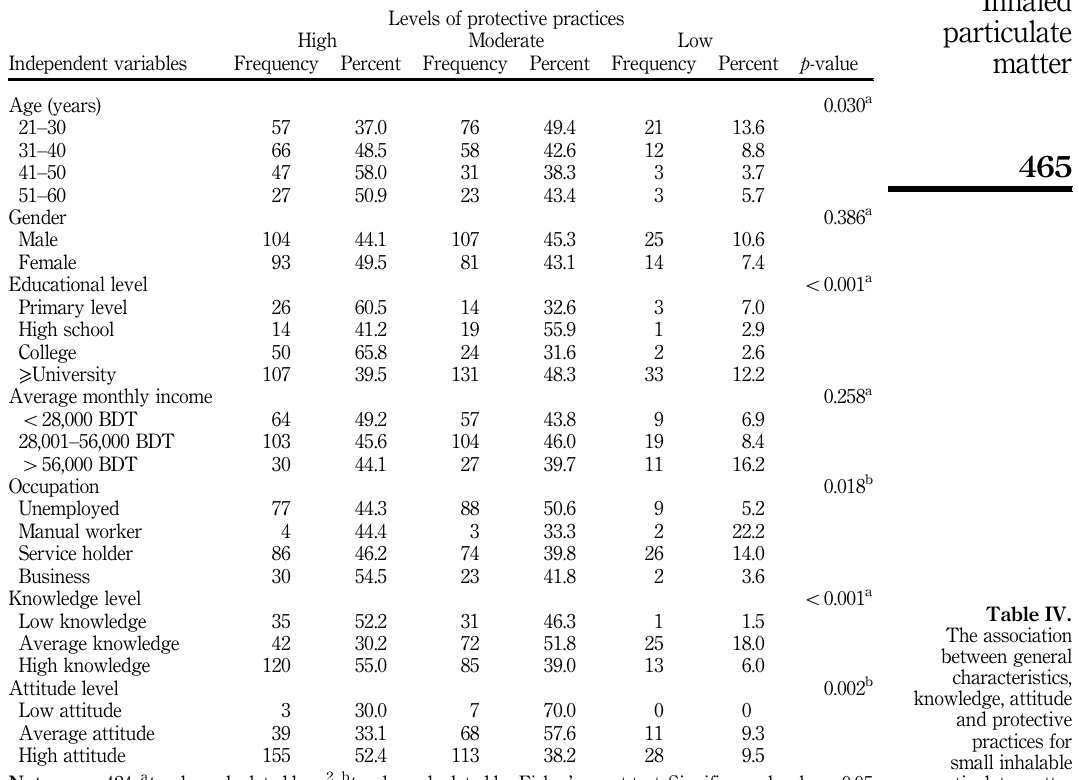
Table IV. The association between general